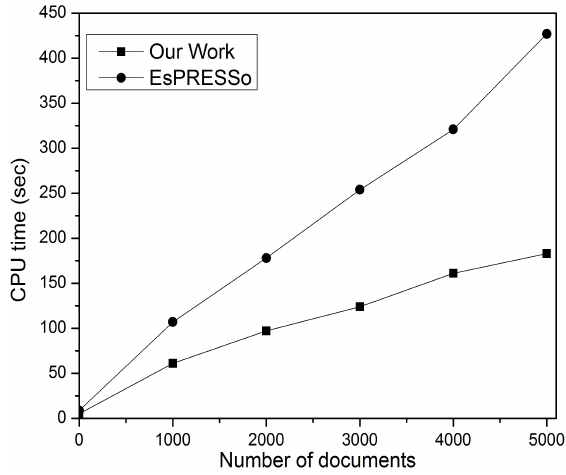
Figure 14. Performance of private and secure DSD (5000 × 5000